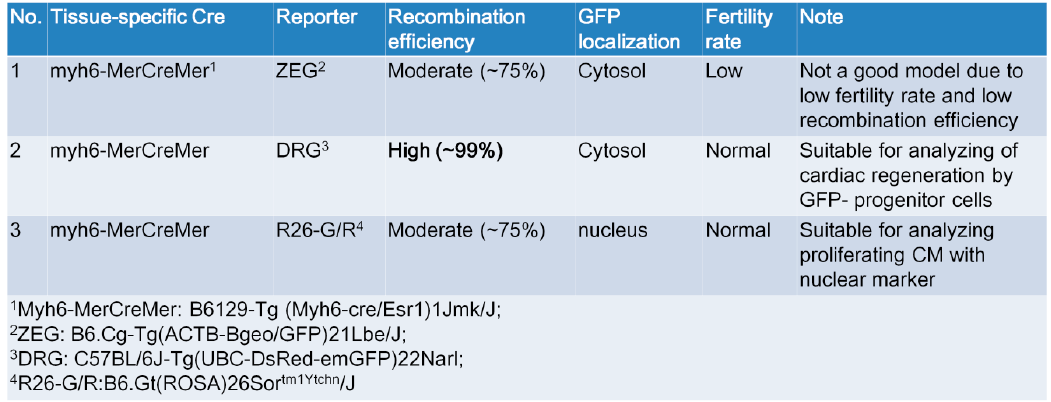
Figure 5. Comparison of the three GFP reporter mice model. The MCM/ZEG mouse model might not be a good model due to the low fertility rate and relatively low recombination efficiency. We identified the MCM/DRG as a better model to replace the MCM/ZEG model, and the MCM/GR as a suitable model for analyzing proliferating cardiomyocytes with nuclear markers.